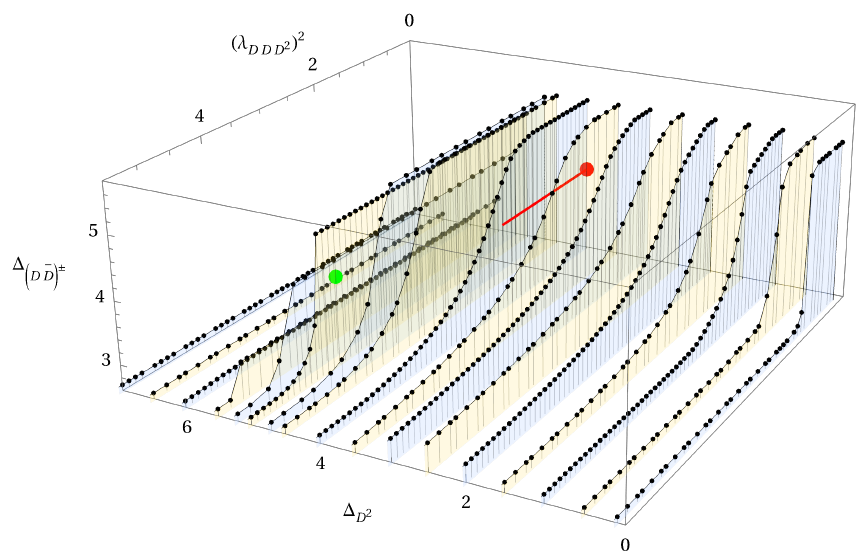
Figure 2. Bounds on the dimension of the first singlet in the D × ¯ D OPE as a function of the gap on the dimension ∆ and the OPE coefficient ( λ ) 2 of the first charged operator in the D × D D 2 DDD 2 OPE. The parity-even and -odd singlets are set to have the same gap: ∆ = ∆ . The ( D ¯ D ) + ( D ¯ D ) − green and red dots correspond to the solutions for GFF and GFB, respectively. Λ = 49 , P = 69